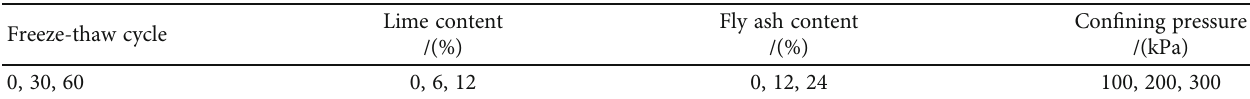
Figure 4: Sample preparation process and freeze-thaw cycle experiment. Table 2: Testing